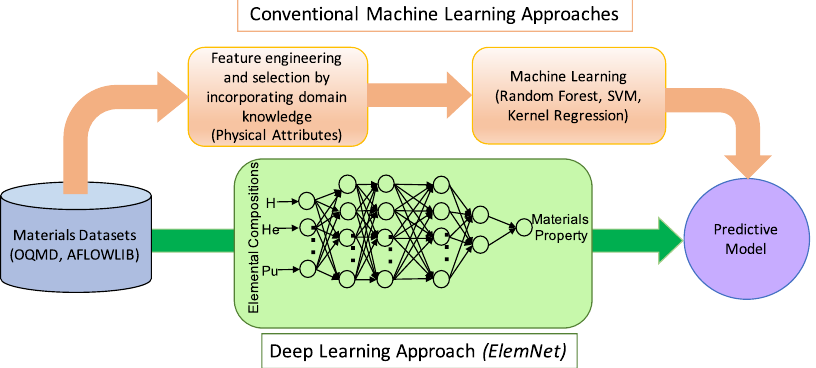
Figure 1. Comparison of deep learning approach with conventional ML approach for prediction of materials properties. The conventional ML approach for predictive modeling of materials properties involve representing the material composition in the model input format, manual feature engineering and selection by incorporating the required domain knowledge and human intuition by computing the important chemical and physical attributes of the constituent elements, and applying ML techniques to construct the predictive models. Our deep learning based predictive approach directly learns to predict properties of materials such as the formation enthalpy from their elemental compositions with better accuracy and speed than conventional ML